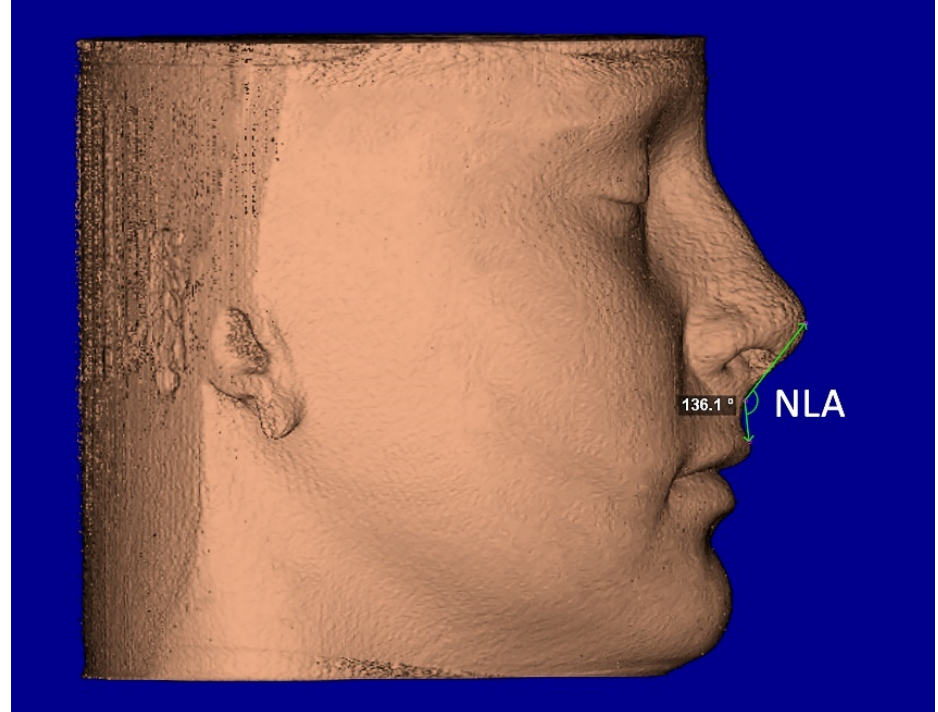
Figure 7. Facial soft-tissue linear measurement of the naso-labial angle (NLA).